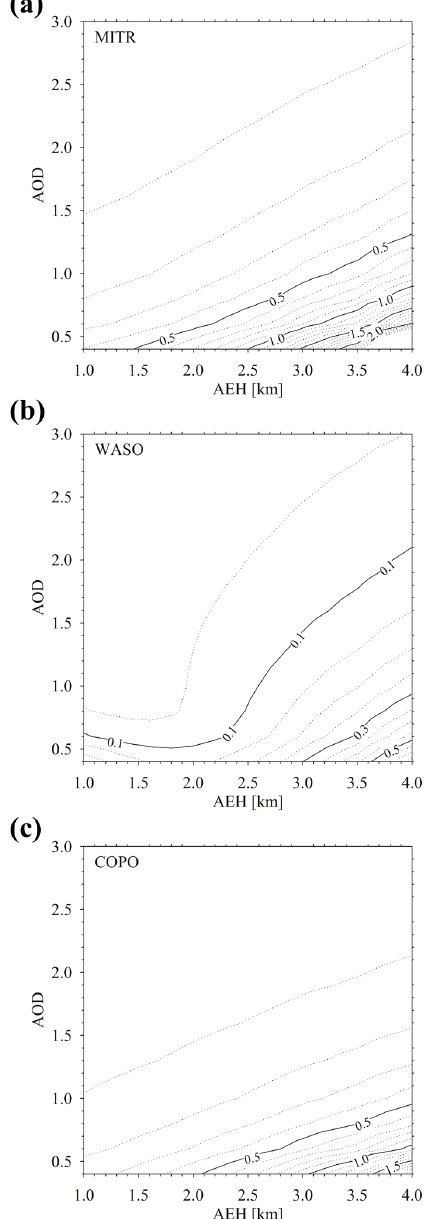
Figure 7. AEH error of (a) MITR, (b) WASO, and (c) COPO for the AOD difference of 0.1 as a function of reference AEH and